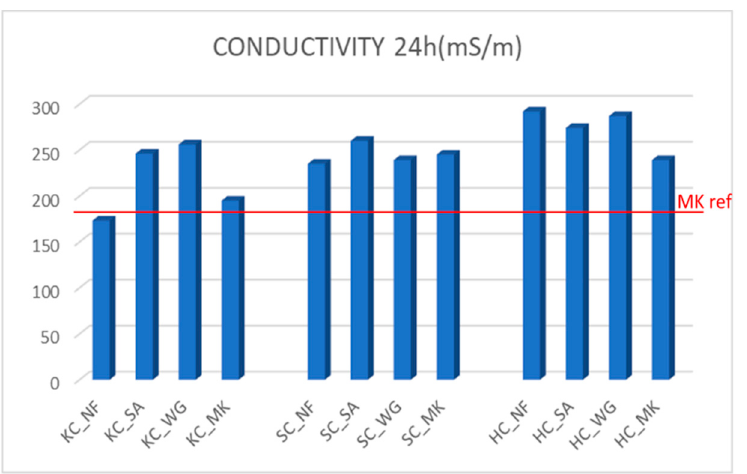
Figure 4. Ionic conductivity values of aal the samples after 24 h from test start. The line MK ref indicates the ionic conductivity of reference geopolymer based on 100% metakaolin.